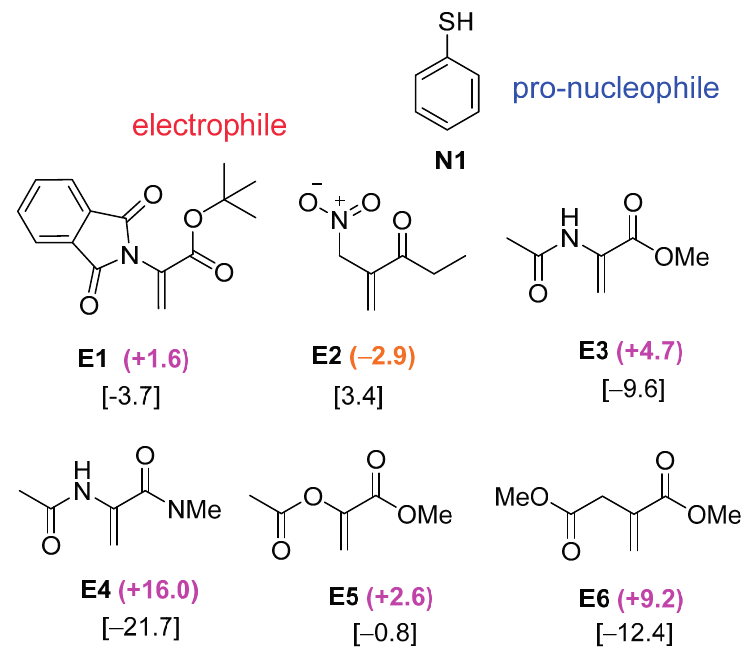
Figure 1. Various electrophiles ( E1 – E6 ) were screened with thiophenol ( N1 ) for bicyclic guanidine-catalyzed conjugate addition reactions. ∆∆ G ≠ values (in kJ · mol − 1 ) are given in parenthesis and the binding free energies (in kJ · mol − 1 ) of the dual hydrogen bonded guanidinium-electrophile complexes are in square bracket.